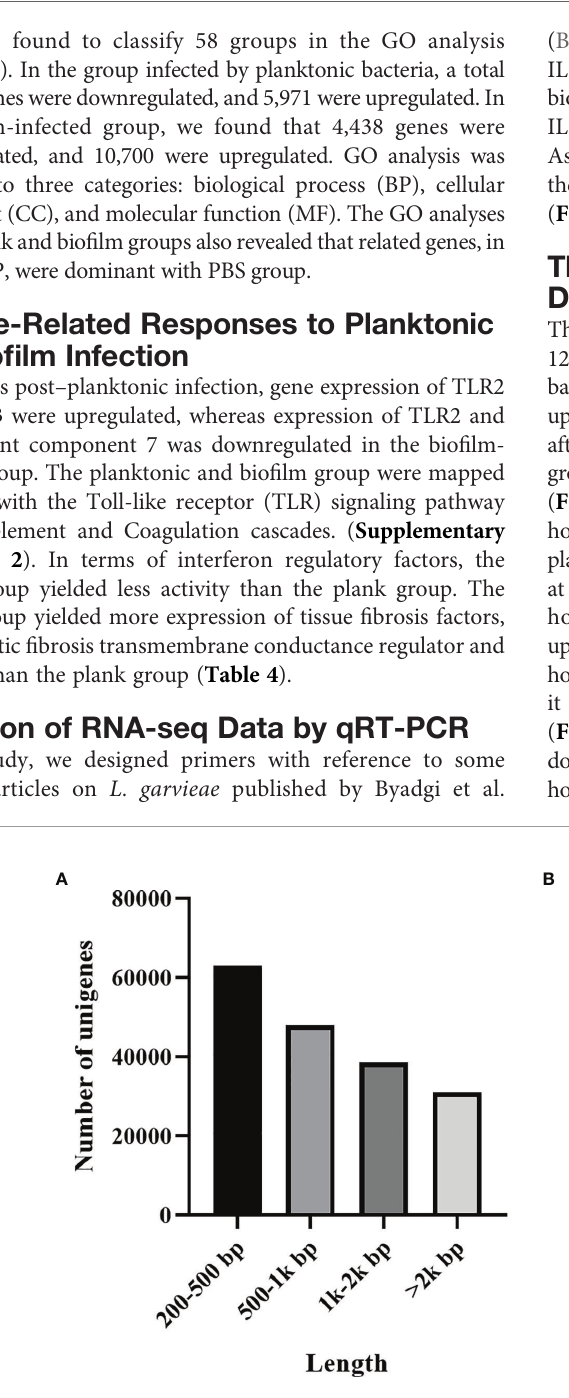
FIGURE 2 | The length distribution of unigenes and contigs. (A) Lactococcus garvieae planktonic- and bio fi lm-infected mullet unigene length distribution. The x-axis indicates the number of unigenes, and the y-axis indicates the length size (bp). (B) Venn diagram of PBS, plank, and bio fi lm intergroup expression.